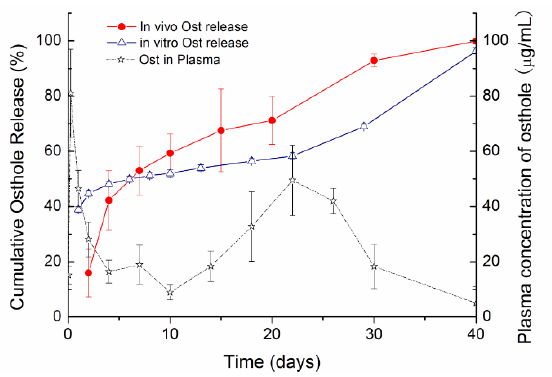
Figure 7. Osthole release from ISFI in vitro and in vivo, and plasma concentrations of Osthole after the administration. (mean ± S.D., n = 3 – 5).